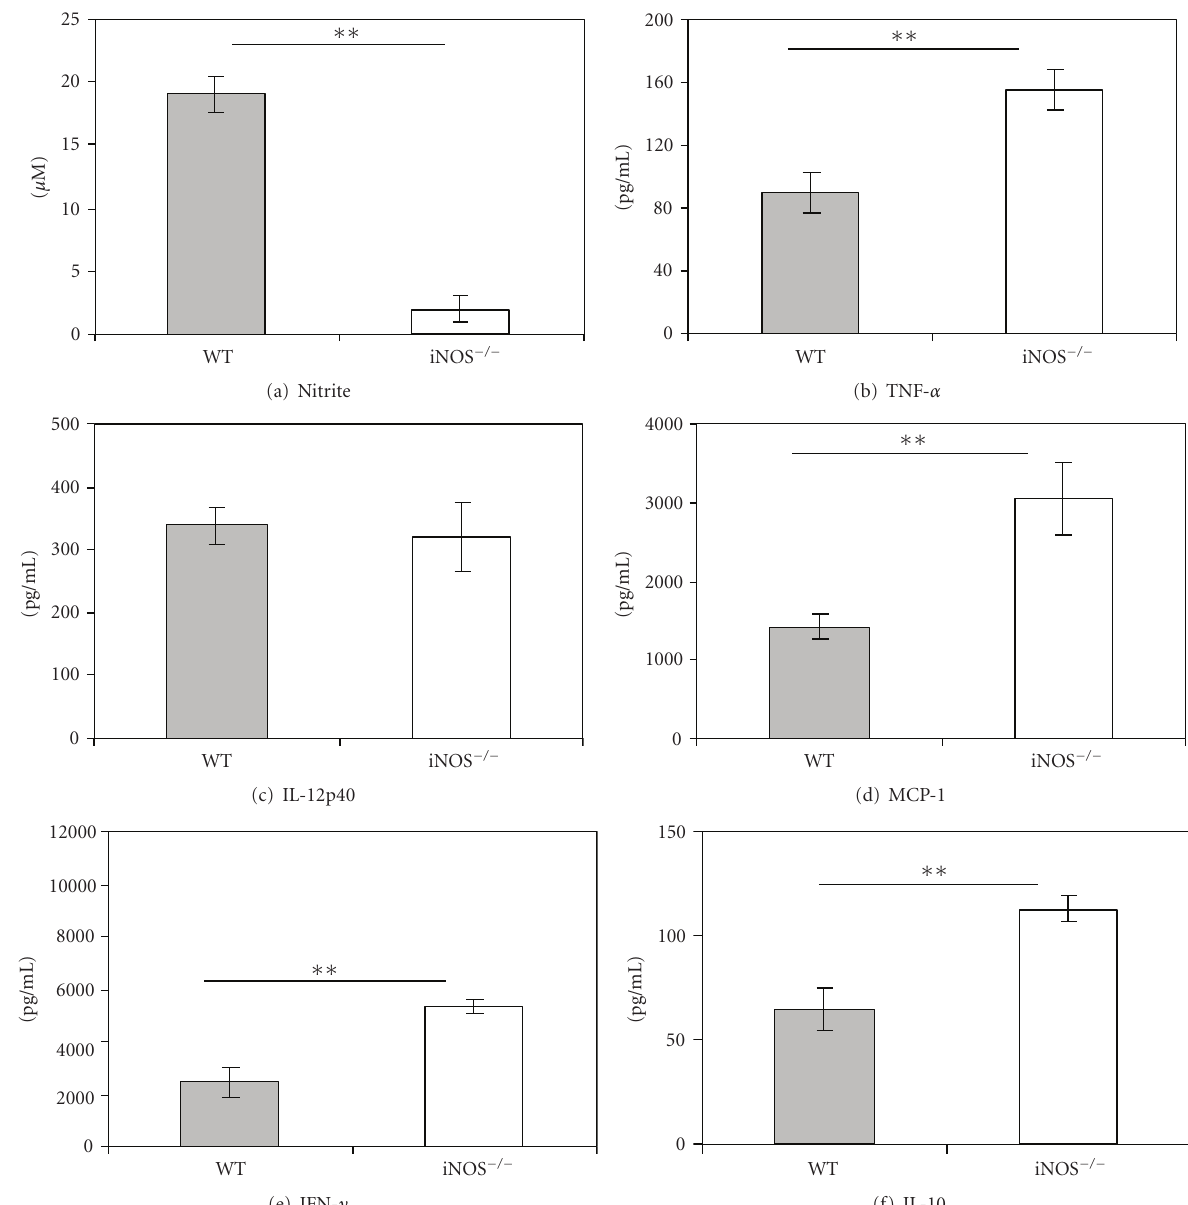
Figure 3: iNOS − / − mice infected with 5 × 10 6 T. congolense produce no detectable nitric oxide but more TNF- α , IL-10, and IFN- γ than infected wild-type (WT) mice. Mice were infected with 5 × 10 6 T. congolense . On day 6 postinfection, spleen cells were cultured at an optimal cell density (5 × 10 6 /mL) for 48 hours. Cytokines in culture supernatants were measured by ELISA, nitrite by the Griess reaction. ∗∗ P < .